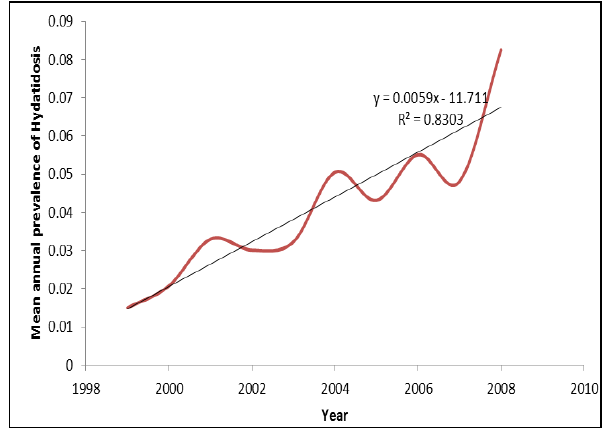
Figure-2: Trend of the number of animals slaughtered and the prevalence of Hydatidosis in ten years.